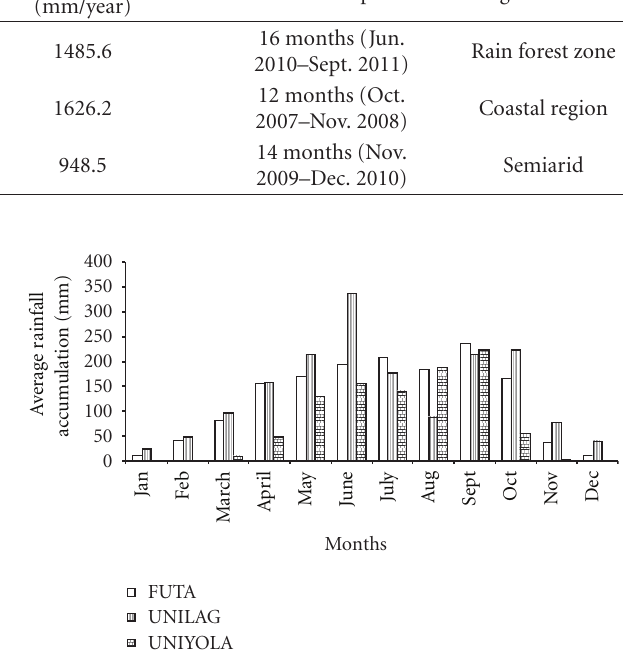
Figure 1: Average monthly rainfall accumulations during the observation